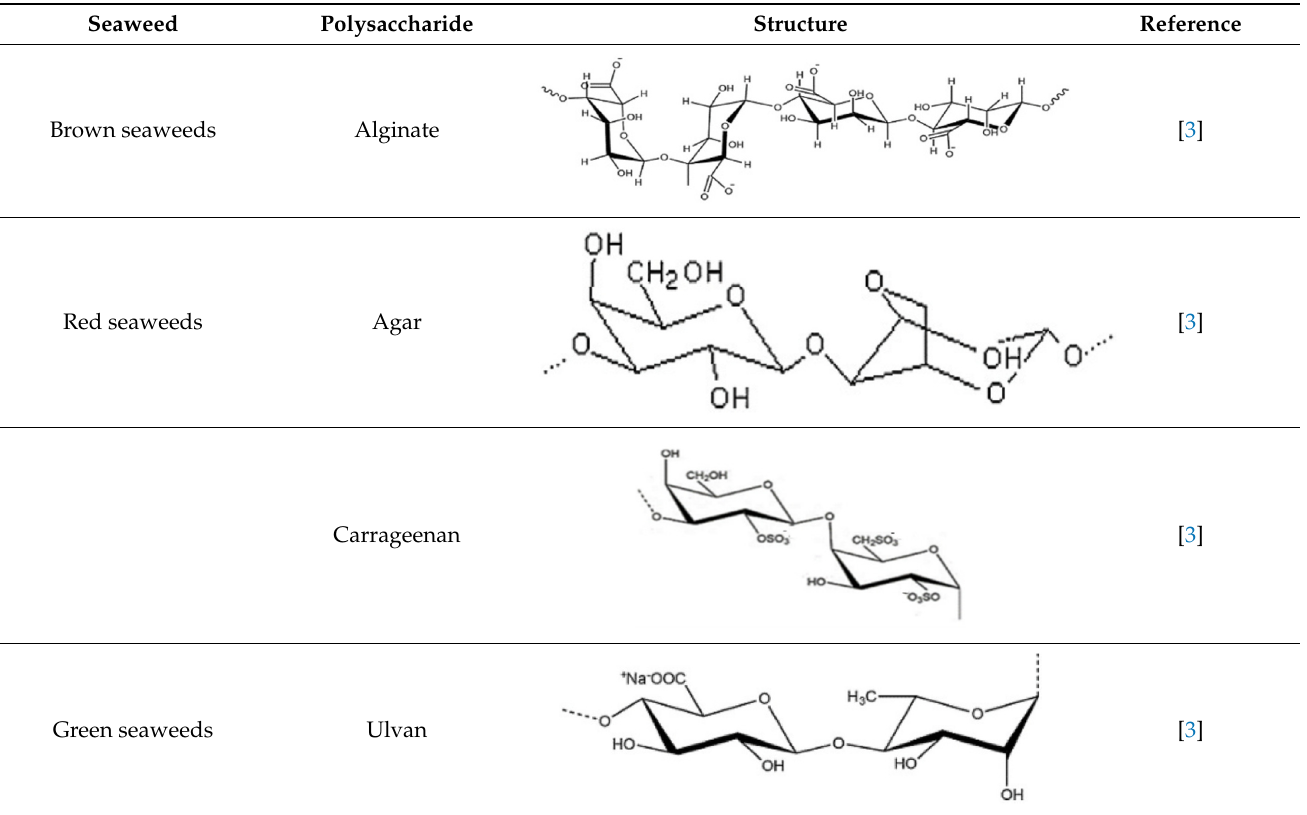
Table 1. Seaweed polysaccharides commonly used as food contact materials.